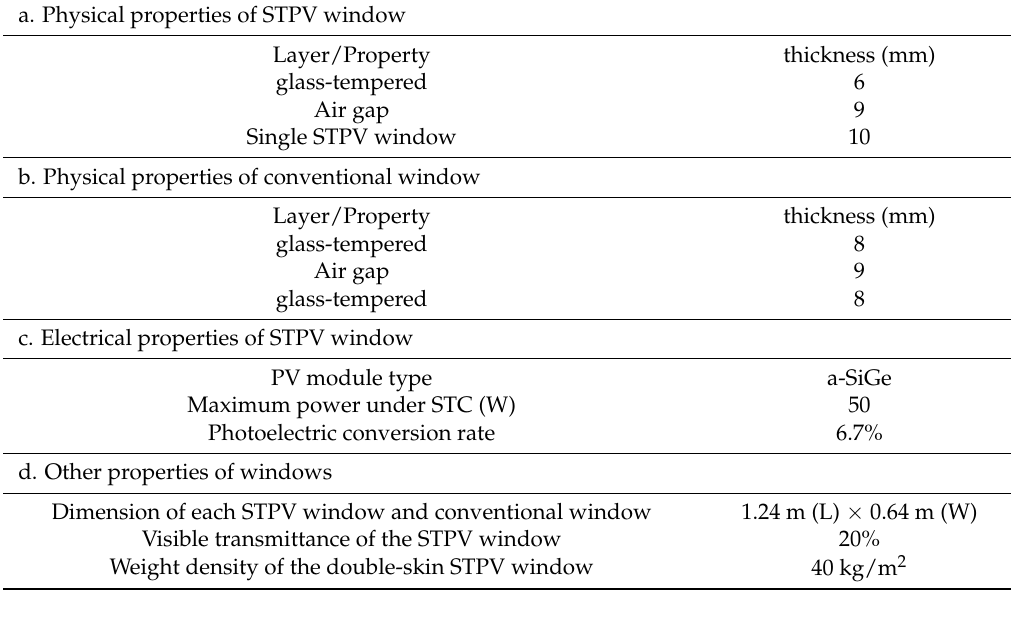
Table 1. Physical and electrical properties of STPV window and conventional window.